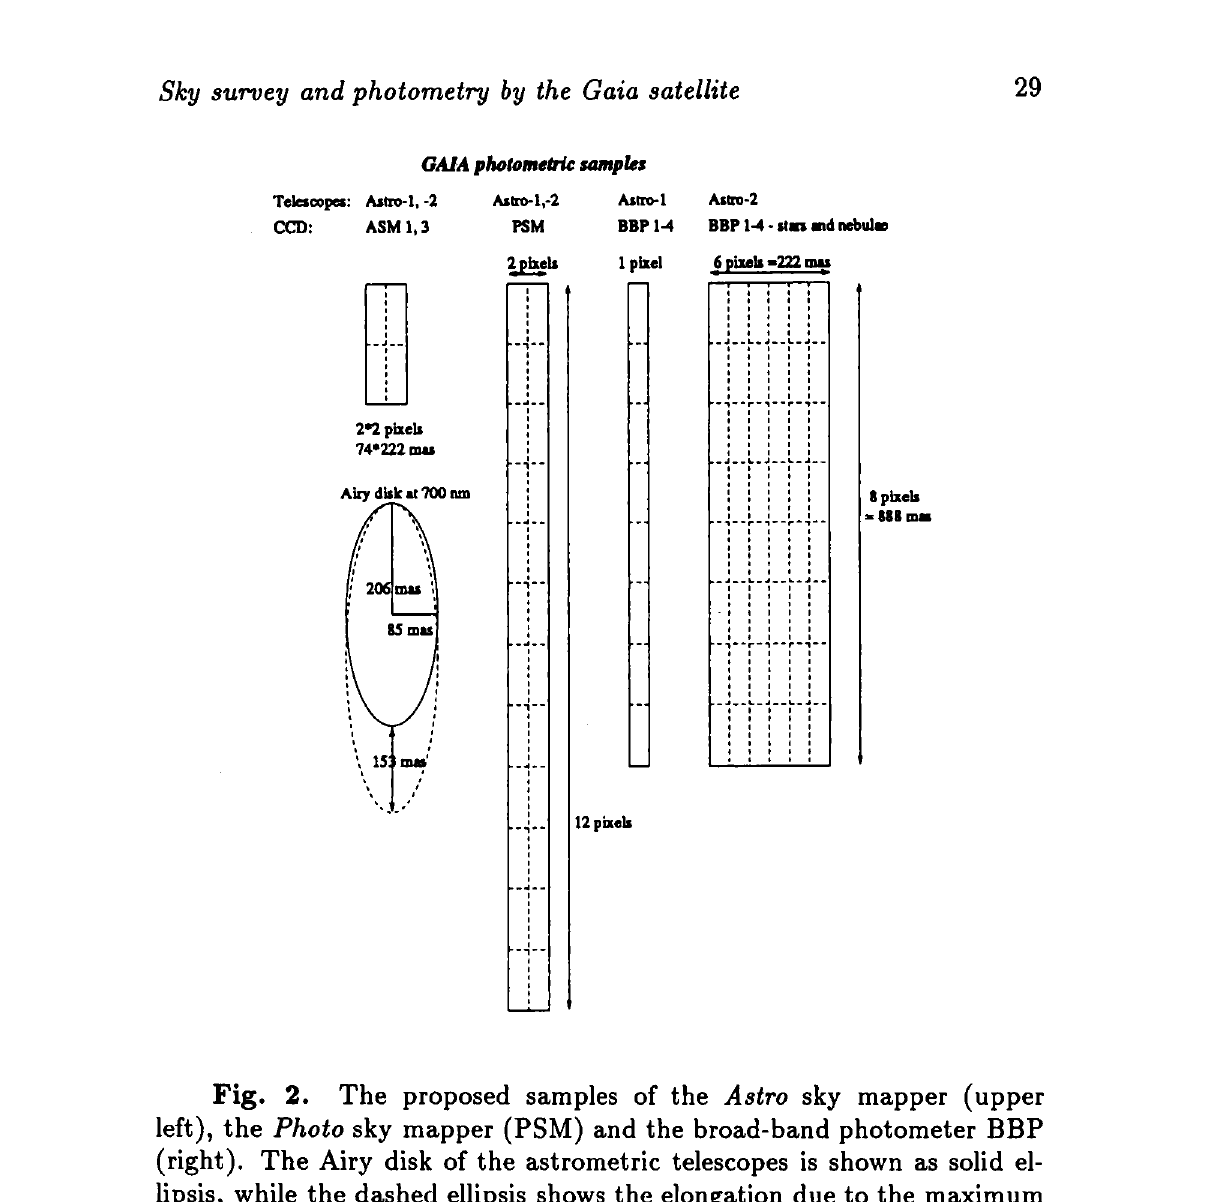
Fig. 2. The proposed samples of the Astro sky mapper (upper left), the Photo sky mapper (PSM) and the broad-band photometer BBP (right). The Airy disk of the astrometric telescopes is shown as solid el- lipsis, while the dashed ellipsis shows the elongation due to the maximum value of cross-scan motion of the image during 0.9 s integration time. The narrow samples of one pixel width along scan will give a resolution of about 50 mas. The broad sample for the BBP in the Astro-2 telescope will give a resolution of about 200 mas and corresponding lower read-out noise. The choice of samples must be guided by the scientifically desirable resolution and the resulting readnoise, thus optimizing the total scientific results from Gaia within certain constraints. The permitted telemetry rate does not appear as a severe constraint for the proposed